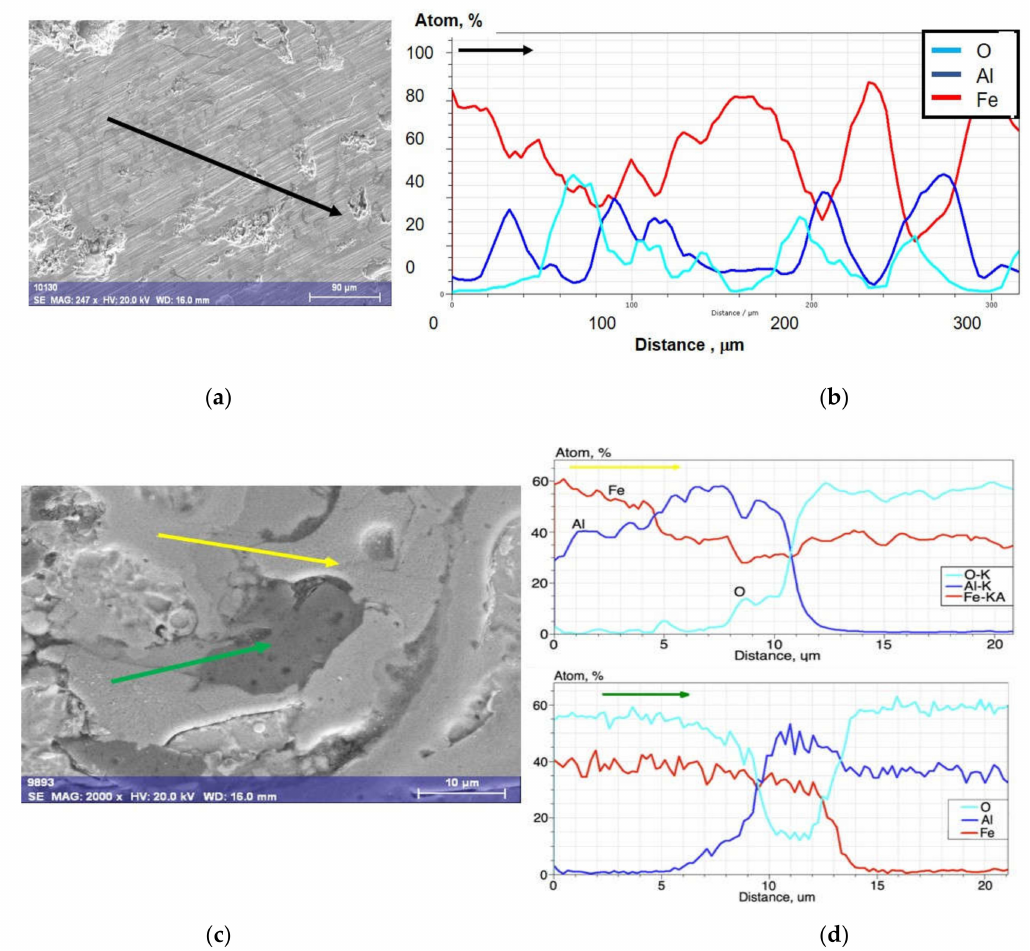
Figure 3. Linear chemical analysis of as-arc-sprayed Fe-Al-type coating after annealing at 700 ◦ C/2 h: ( a ) SE image of the surface of the coating, ( b ) linear distribution of elements along the black arrow marked on Figure 3a, ( c ) SE image with details of the layer cross-section, ( d ) linear distribution of elements along the yellow and green arrows marked on Figure 3c.